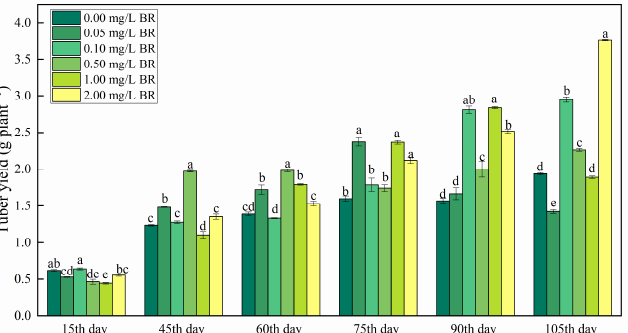
Figure 1. The change in tuber yield of P. ternata at different stages after BR treatments. The bars with different letters are significantly different from each other at the same stage after BR treatments ( p < 0.05). Values are means of four replicates ± SE.